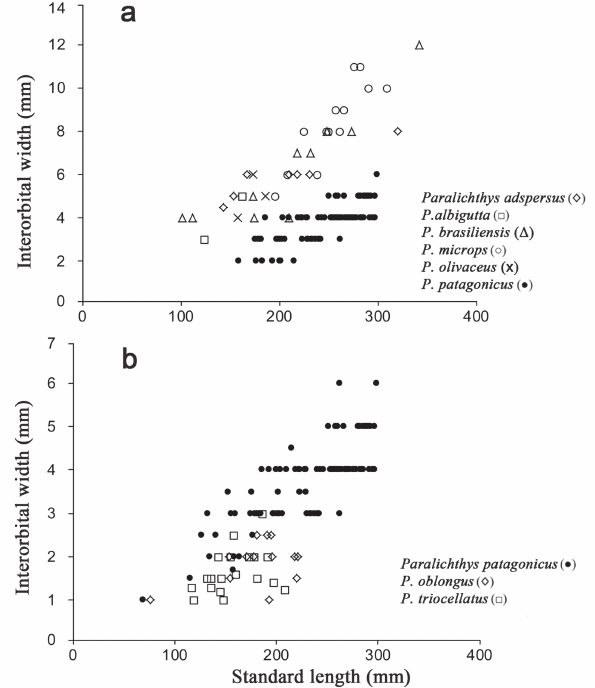
Fig. 10. Relationships of interorbital width to standard length in Paralichthys adspersus , P. albigutta , P. brasiliensis , P. microps , P. olivaceus and P. patagonicus ( a ). Relationships of interorbital width to standard length ( b ) in Paralichthys patagonicus , P. oblongus and P. triocellatus